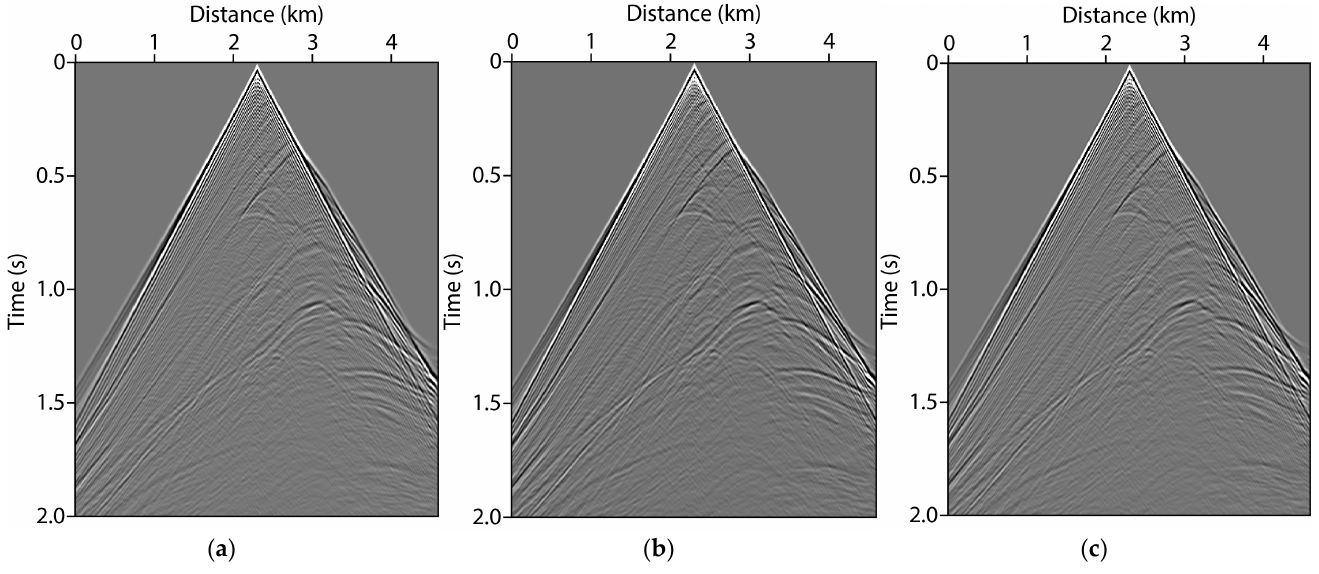
Figure 9. Shot records simulated by the: ( a ) CFD4 scheme, ( b ) CFD6 scheme, ( c ) OCFD4 (0.5 π ).